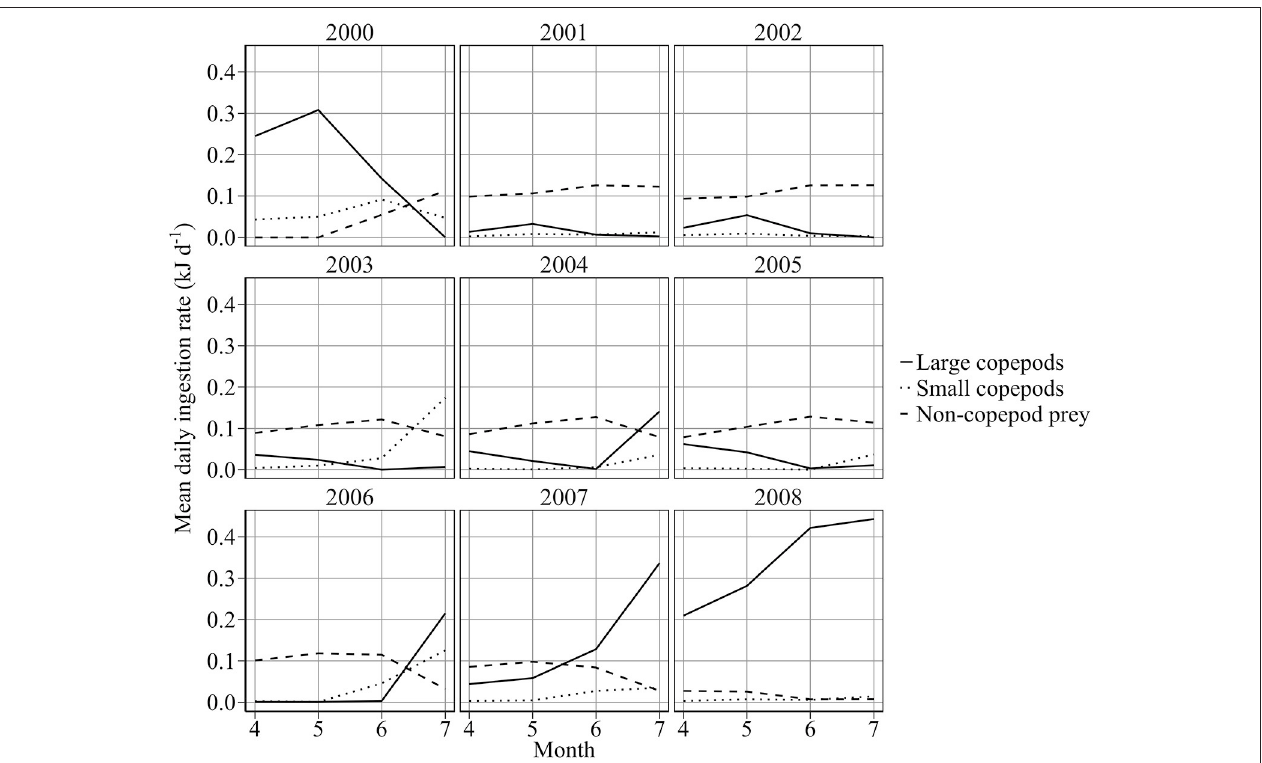
FIGURE 8 | Modeled mean daily ingestion rate ( kJ d − 1 ) of a 6cm sandeel feeding on large, small, and non-copepod